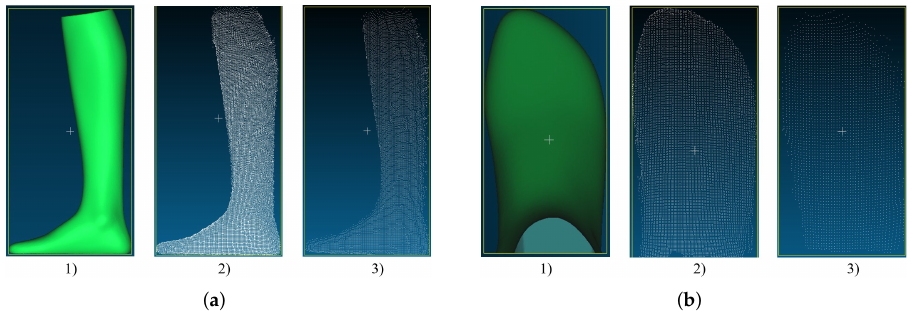
Figure 9. Example of point clouds recorded with the Microsoft Kinect Azure ToF camera: ( a ) point clouds of the foot model generated for length measurement: (1) GT; (2) length measurement (500 mm); (3) length measurement (1000 mm); ( b ) point clouds of the foot model generated for width measure- ment: (1) GT; (2) width measurement (500 mm); (3) width measurement (1000